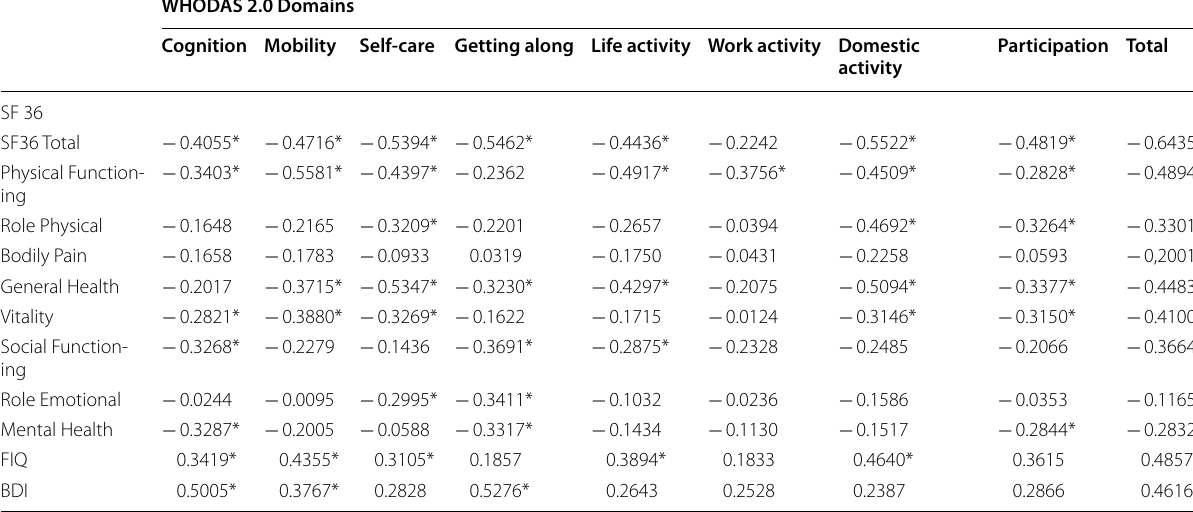
Table 4 Correlation coefficient matrix between the domains of WHODAS 2.0, SF36, BDI and